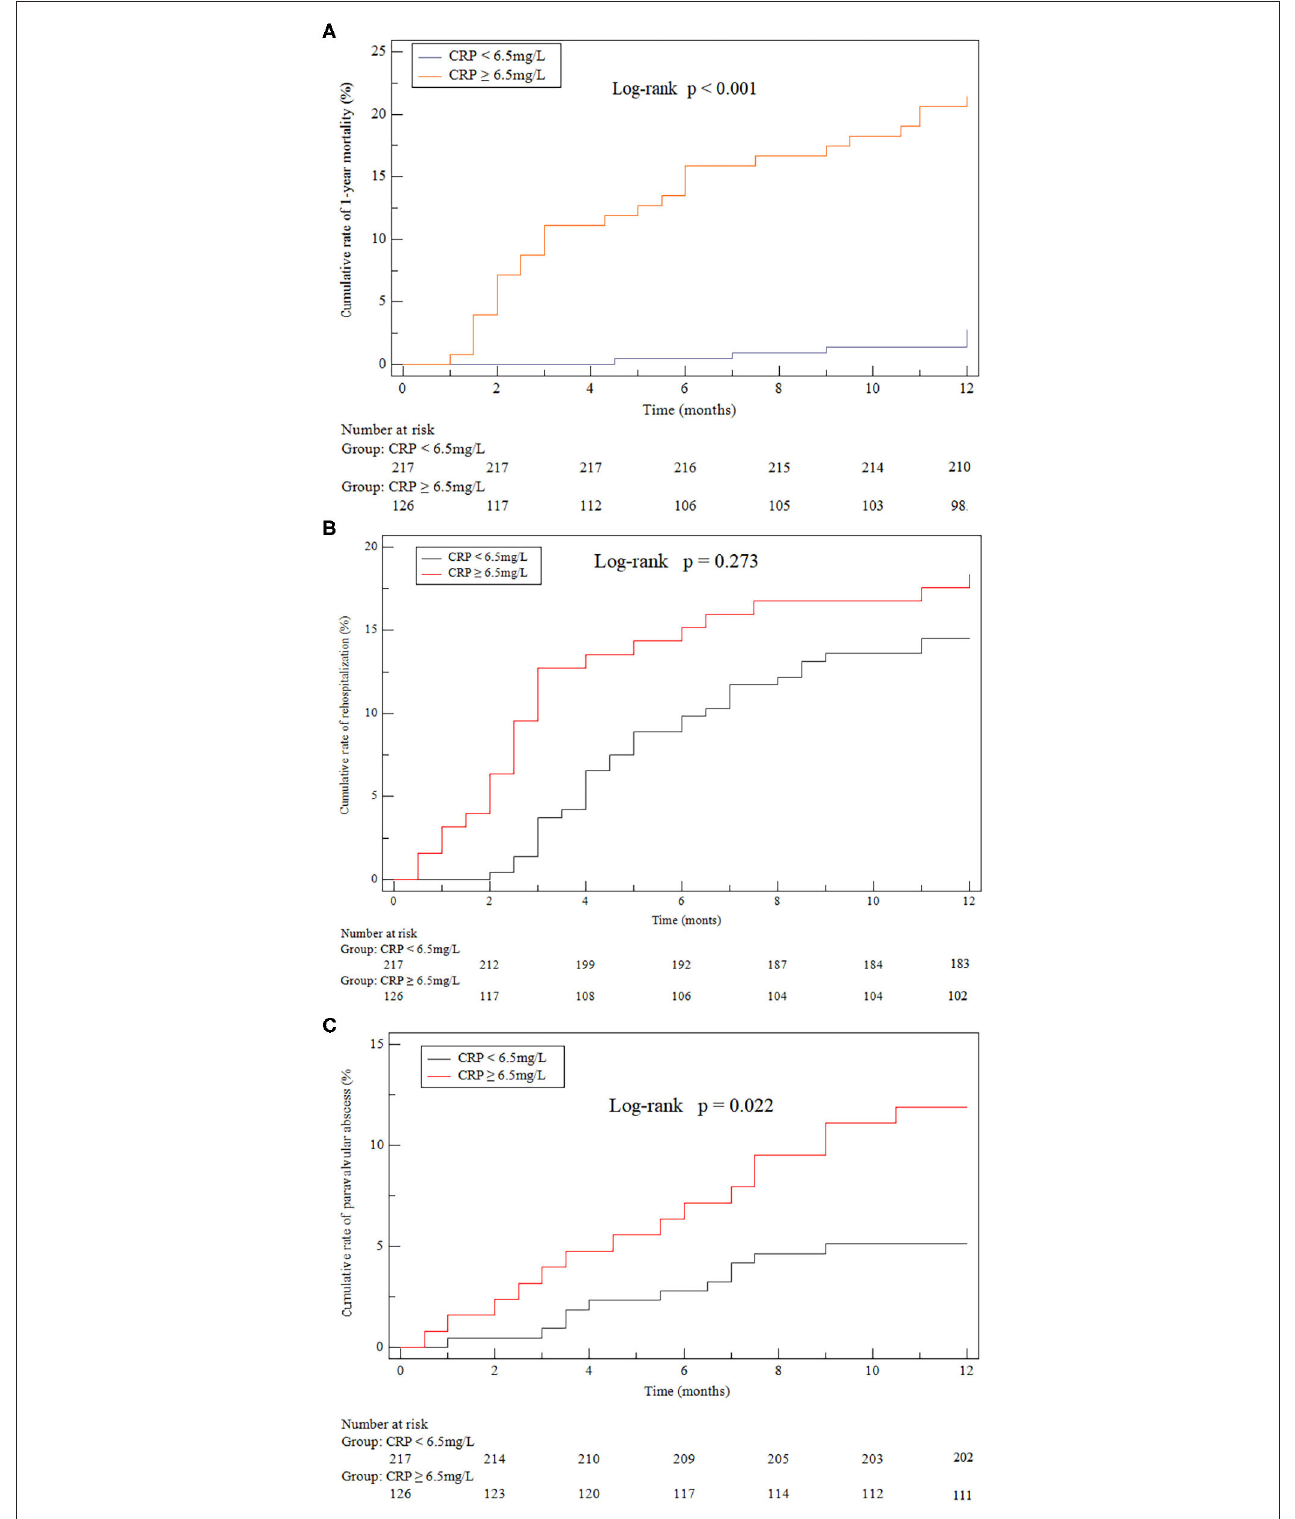
FIGURE 4 | Kaplan-Meier curves. (A) all-cause death after discharge (21.43% cf. 2.76%, P < 0.001). (B) Heart failure hospitalizations after discharge (18.25% cf. 14.29%, P = 0.273). (C) Paravalvular (11.90% cf. 5.07%, P = 0.022) abscess identified by echocardiogram after discharge compared between the high-CRP and low-CRP